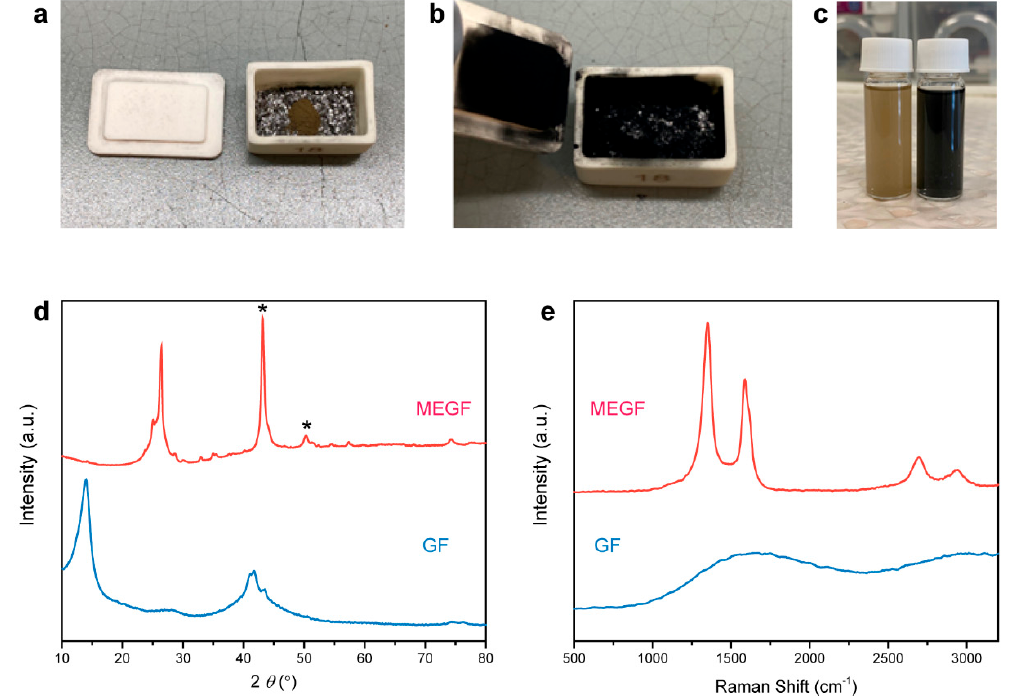
Figure 1. Photographs of GF before ( a ) and after ( b ) graphite-mediated, microwave-induced reaction that caused a significant expansion of GF and a color change from brown to black. The GF powder is placed on top of graphite flakes contained in an alumina crucible. ( c ) Photograph of GF (left) and MEGF (right) dispersed in ethanol showing brown and black colors, respectively. Powder XRD patterns ( d ) and Raman spectra ( e ) of GF and MEGF. The * peaks in ( d ) result from the XRD sample holder due to the low packing density of the fluffy MEGF